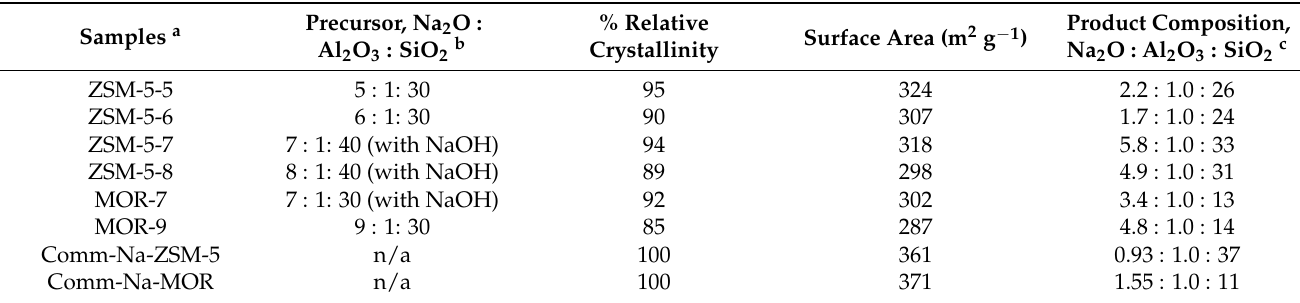
Table 3. Comparison of physical and chemical properties of selected single-phase zeolites. (Reprinted from [44]. Published by The Royal Society of Chemistry).